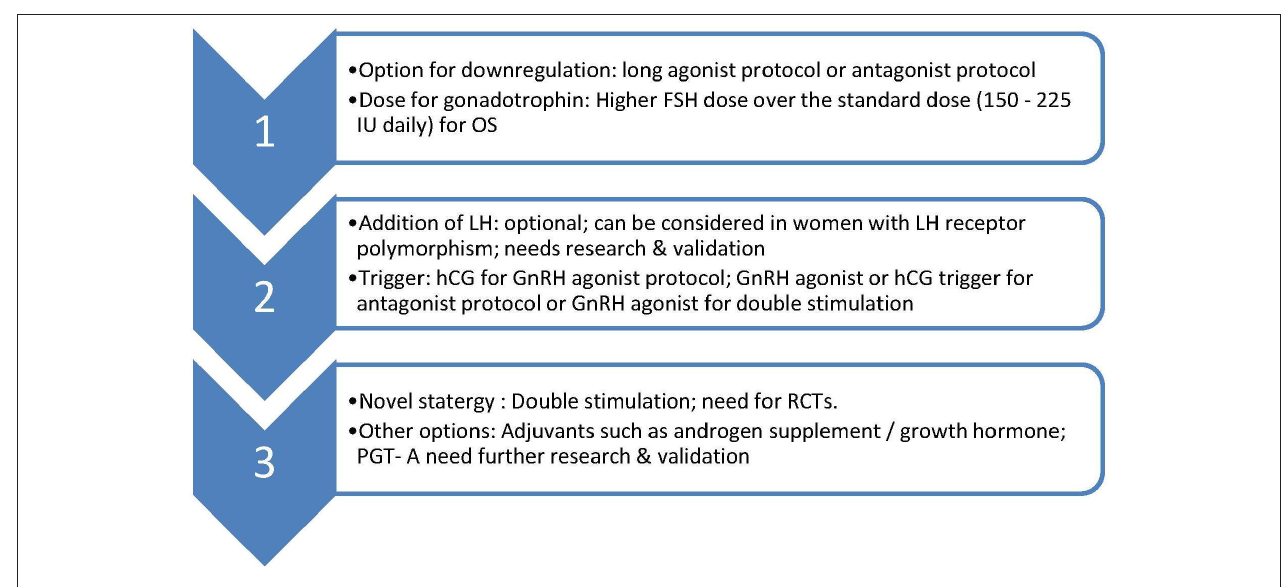
FIGURE 1 | Suggested management of POSEIDON group 2. OS, ovarian stimulation; LH, luteinising hormone; hCG, human chorionic gonadotrophin; GnRH, Gonadotrophin releasing hormone; PGT-A, pre implantation genetic testing-aneuploidy; RCT, randomized controlled